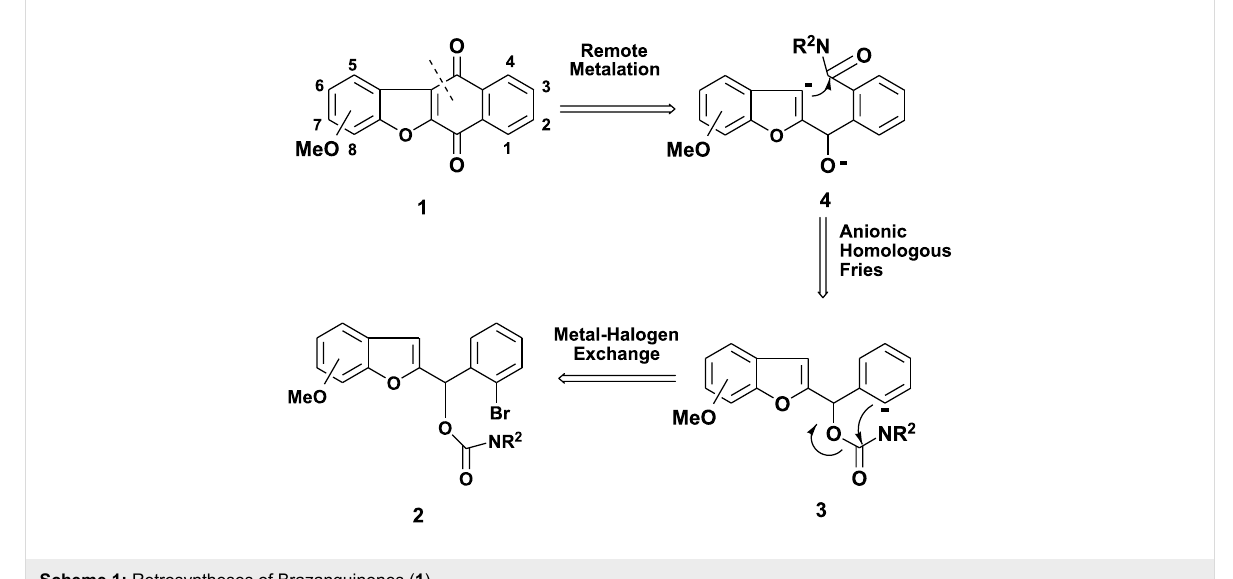
Scheme 1: Retrosyntheses of Brazanquinones ( 1